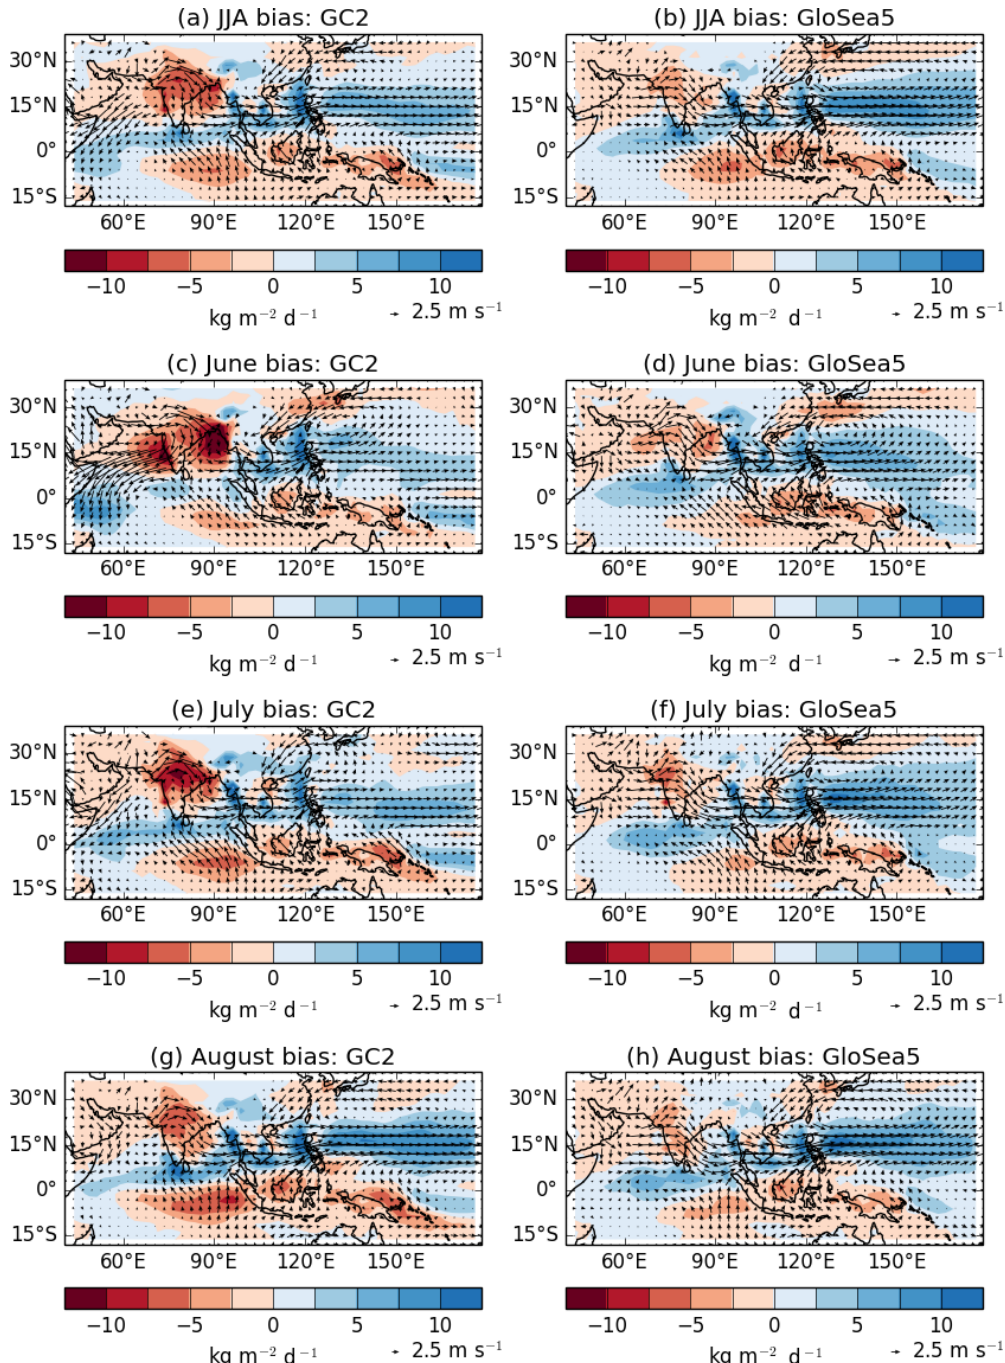
Figure 1. (a, b) JJA, (c, d) June, (e, f) July and (g, h) August climatological errors in precipitation (against GPCP observations) and 850hPa winds (against ERA-Interim reanalyses) from the current GloSea5 23-year operational hindcast ensemble initialised each year on four start dates (1, 9, 17, 25) in April, May, June and July, respectively, with seven members per start date.